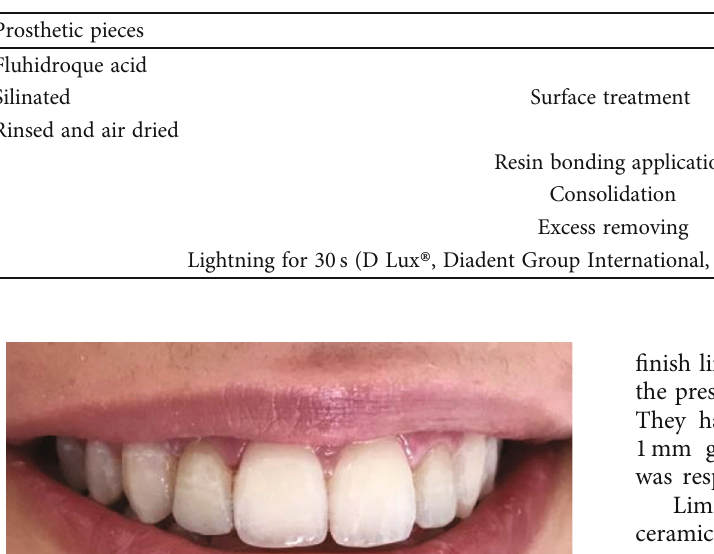
Figure 8: Intraoral checking of the three-quarter crowns. Table 1: The bonding procedure steps (Ivoclar Vivadent, Schaan, Liechtenstein).